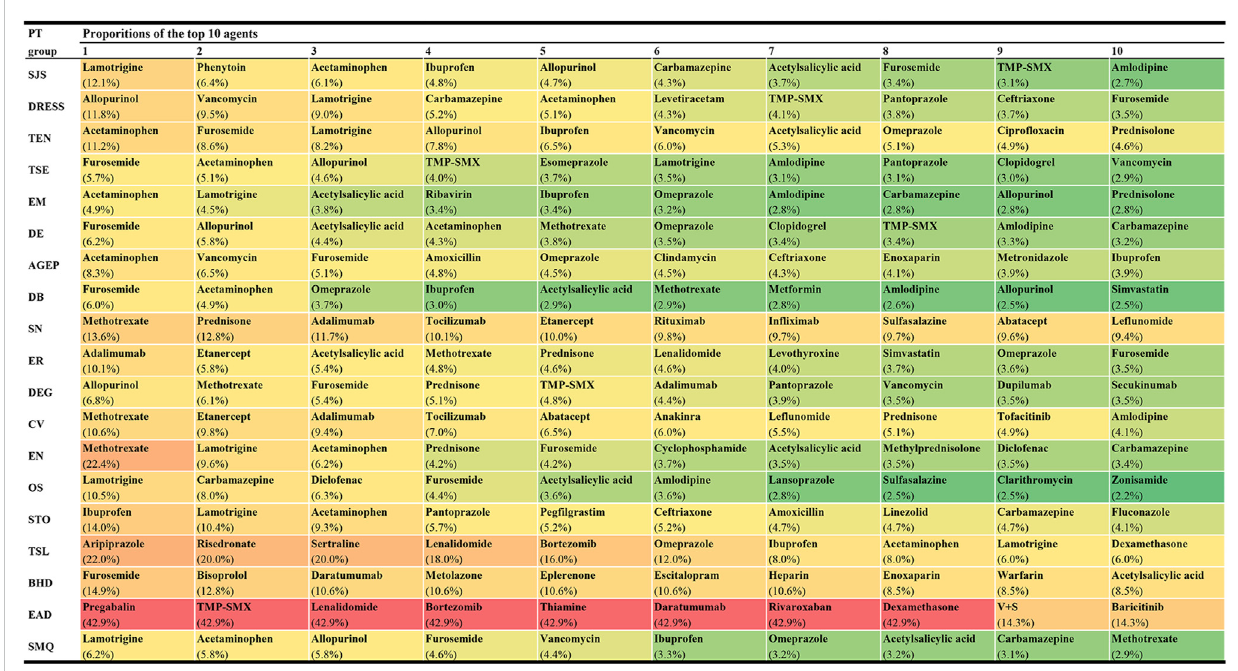
FIGURE 3 Top 10 agents with the highest reporting proportions at the SMQ and PT levels. AGEP, acute generalised exanthematous pustulosis; BHD, bullous haemorrhagic dermatosis; CV, cutaneous vasculitis; DB, dermatitis bullous; DE, dermatitis exfoliative; DEG, dermatitis exfoliative generalized; DRESS, drug reaction with eosinophilia and systemic symptoms; EN, epidermal necrosis; EM, erythema multiforme; EAD, erythrodermic atopic dermatitis; ER, exfoliative rash;OS, oculomucocutaneous syndrome; PT,preferred term;SCARs, severe cutaneous adverse reactions; SMQ,StandardizedMedDRA Queries; STO, SJS-TEN overlap; SN, skin necrosis; SJS, Stevens-Johnson syndrome; TMP-SMX, sulfamethoxazole and trimethoprim; TSL, target skin lesion; TEN, toxic epidermal necrolysis; TSE, toxic skin eruption; V+S, velpatasvir and